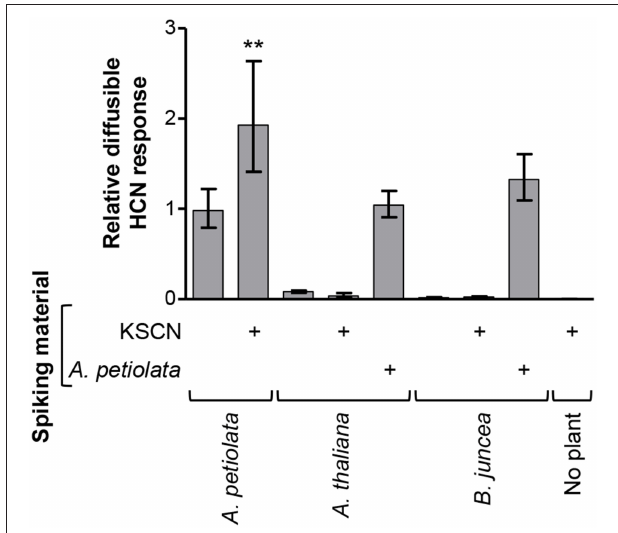
FIGURE 8 | The glucosinolate-derived diffusible HCN response is not general to the Brassicaceae. A. thaliana and B. juncea were investigated for their ability to provide a diffusible HCN response from endogenous glucosinolates or from exogenously added KSCN. The response in the König reaction-based diffusion assay was quantified relative to the mean of unspiked A. petiolata samples and a one-tailed unpaired t -test was performed on the log 10 -transformed ratios. Bars represent back-transformed mean ± SD. ( ** P < 0.01 ; n = 4 ).